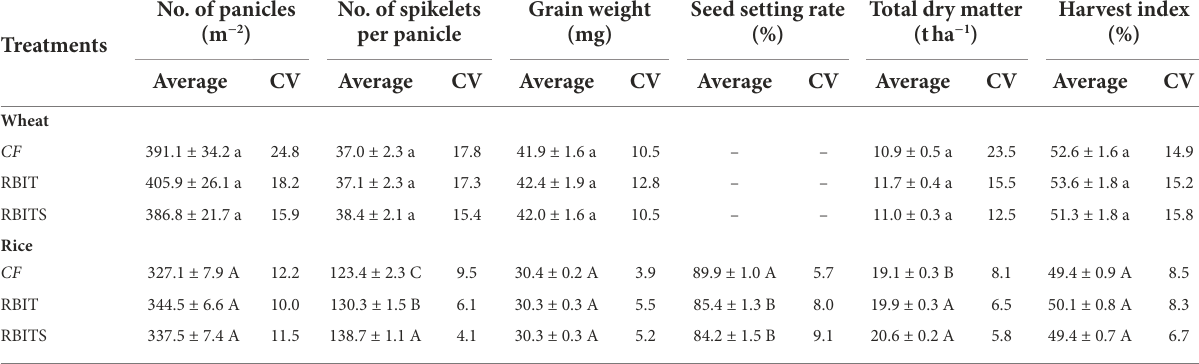
TABLE 3 Effect of fertilization management on yield components(No. of panicles, No.of spikelets per panicle, grain weight, seed setting rate), dry matter accumulation and harvest index and their coefficients of variation.